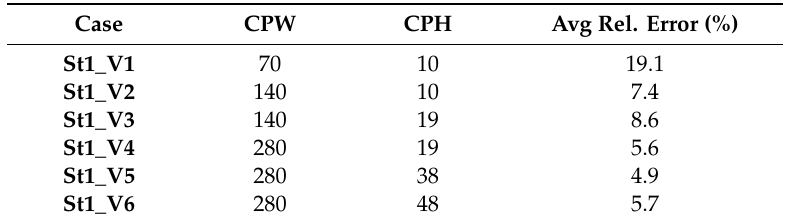
Table 1. Cell sizes considered in the mesh sensitivity study for the generated wave of height 0.038 m